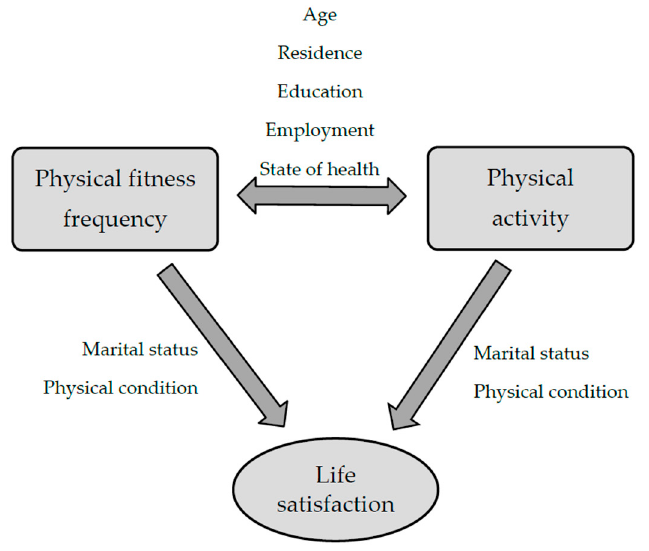
Figure 4. Factors affecting the level of life satisfaction according to the SWLS scale